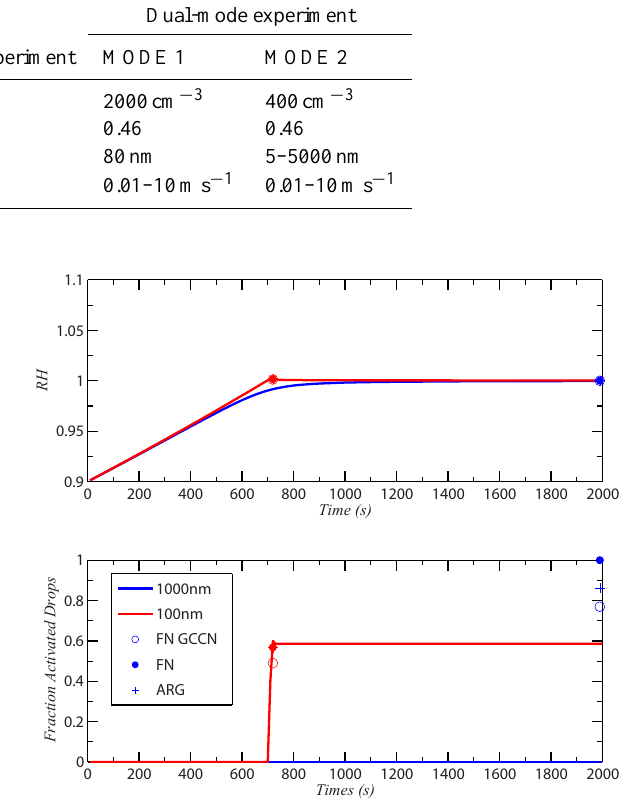
Figure 1. Time series of RH (top panel) and fraction of acti- vated drops (bottom panel) as calculated by ACPIM with ini- tial conditions described in Table 1, a number concentration of aerosol 500cm − 3 , with median aerosol diameters 100nm (red) and 1000nm (blue). Using the same initial conditions, results from the parameterisations are plotted as single points at the time of maxi- mum supersaturation (which is calculated from the parcel